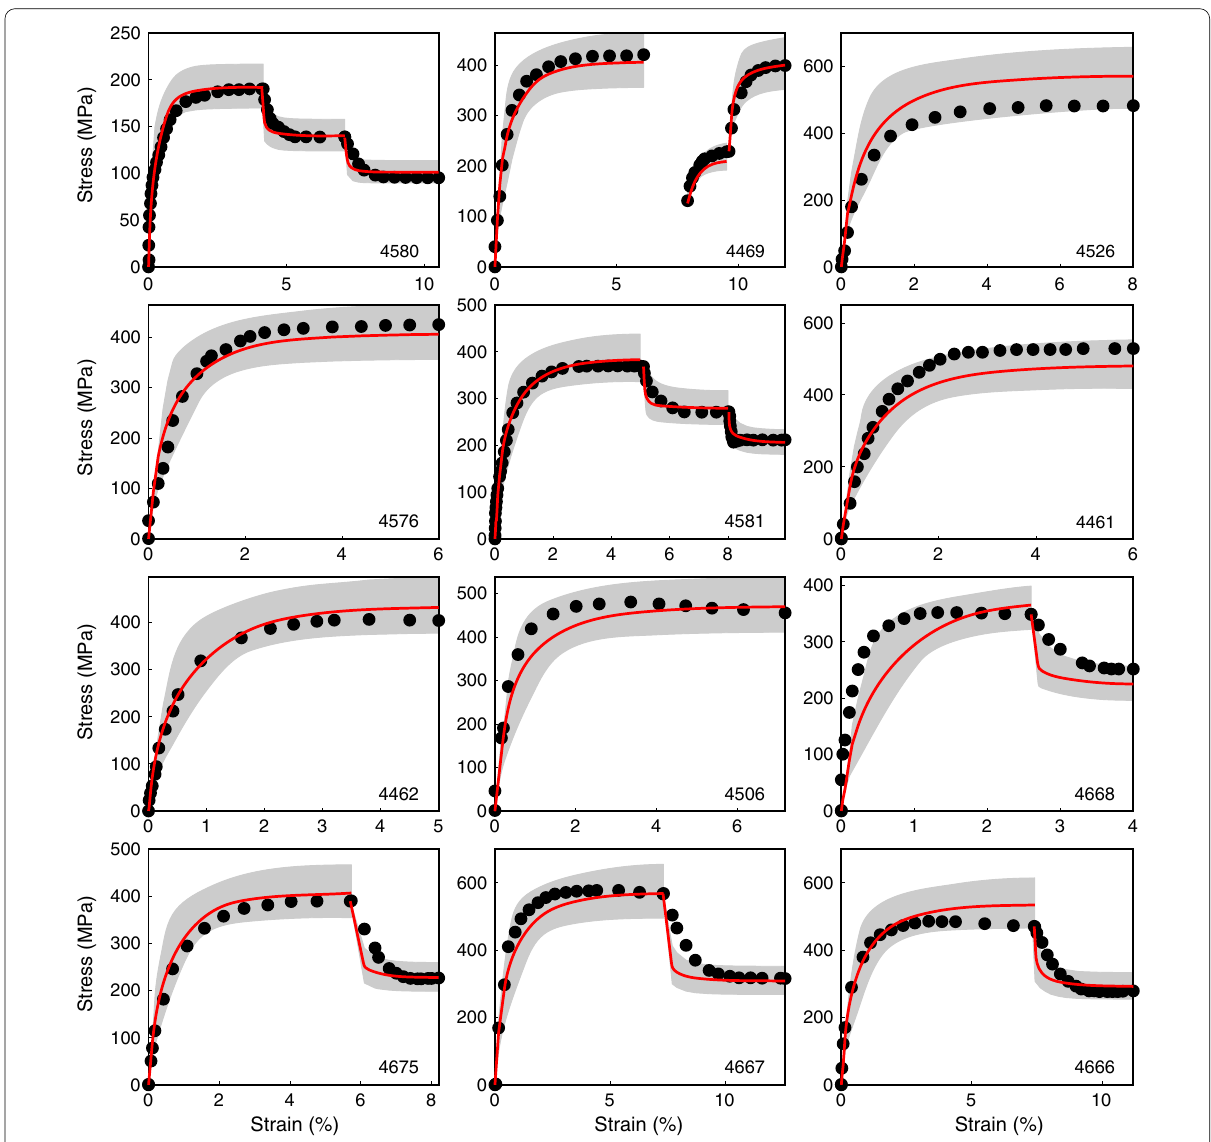
Fig. 4 Stress-versus-strain series data (black dots) for dunites with best-fit models. The red line represents the best-fit model prediction with the nonlinear Burgers constitutive law. The grey band represents the confidence interval of the forward model, which is plotted by randomly sampling the posterior distribution taking the covariance into